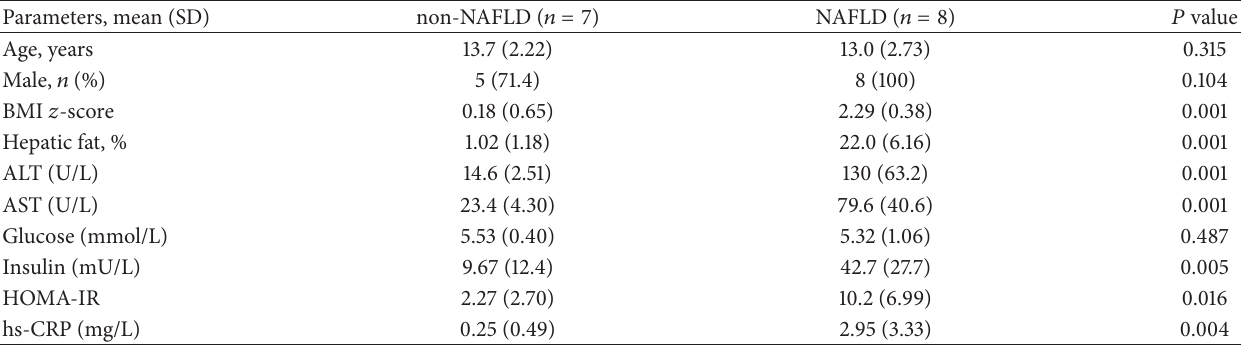
Table 2: Baseline characteristics of the 8 adolescents with biopsy-proven NAFLD and the 7 healthy controls: study cohort 2.